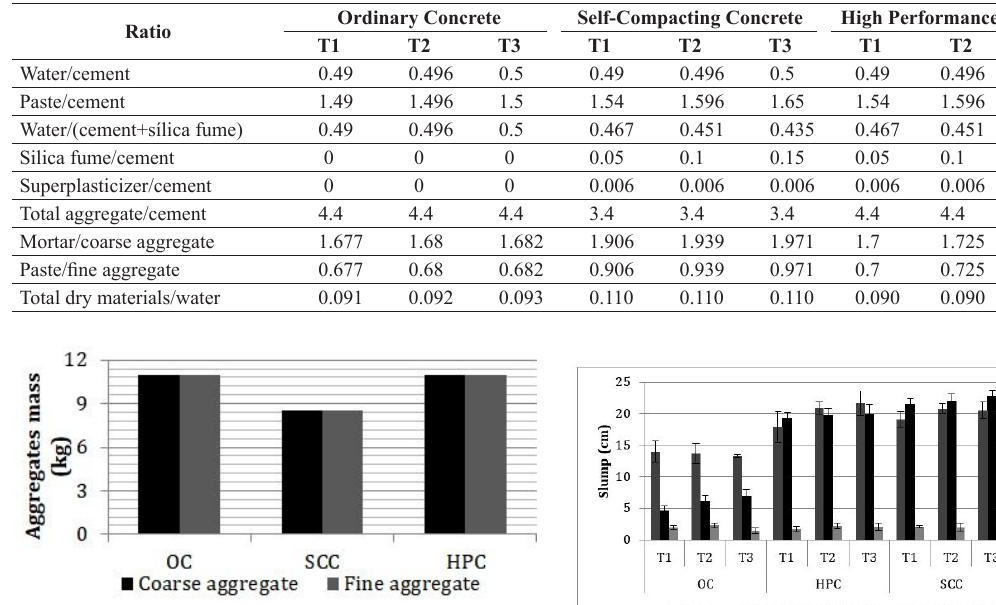
Table 2. Ratio of materials of concrete